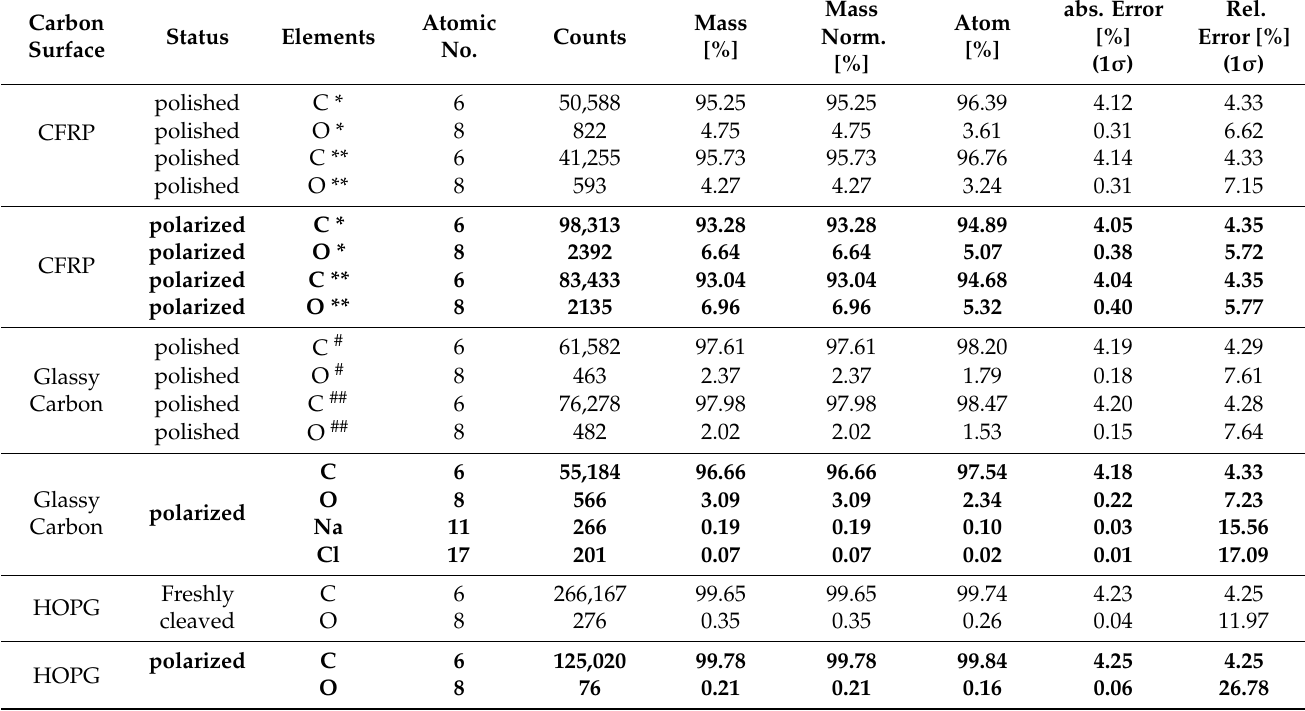
Table 1. Table of elemental compositions of carbon surfaces determined by energy-dispersive X-ray spectroscopy (EDS) before and after polarization in a 50 mM NaCl